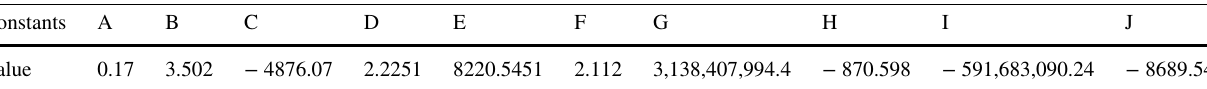
Table 11 The constants determined with n =